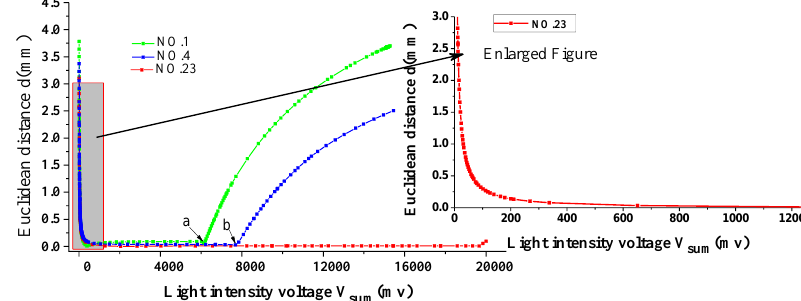
Figure 10. The Euclidean distance between the ideal spot position and the incidence spot position calculated according to Equations (1) and (2) with different light intensity.